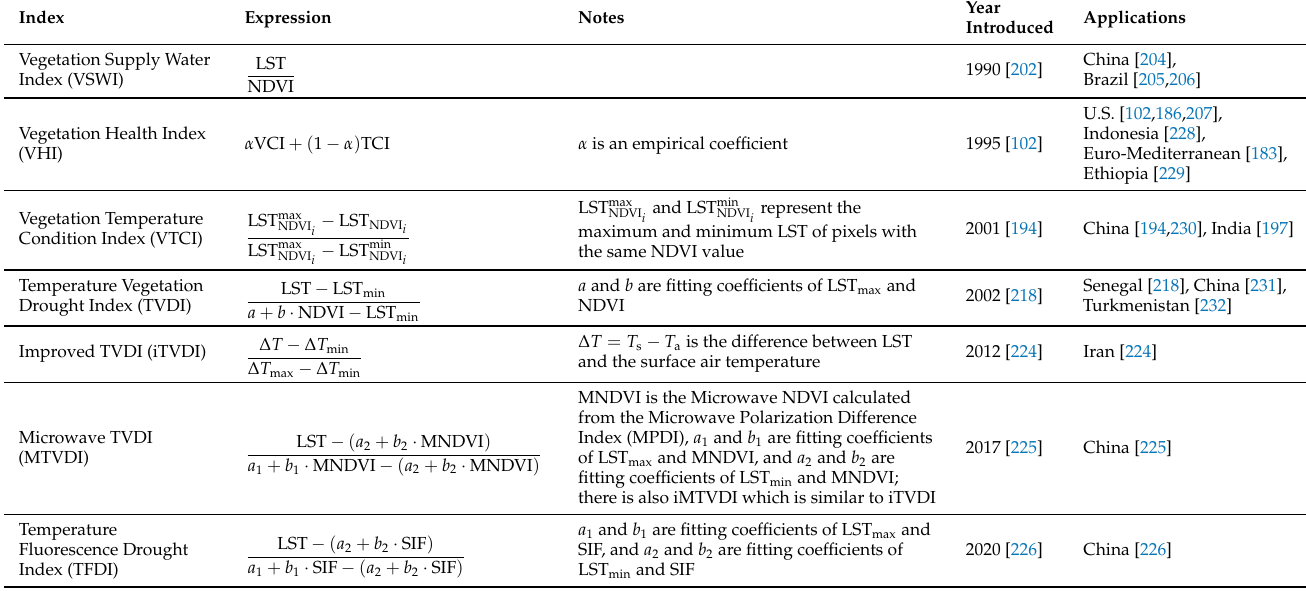
Table 4 gives an overview of the drought indices in this section. Table 4. Summary of optical-thermal combined indices suitable for agricultural drought